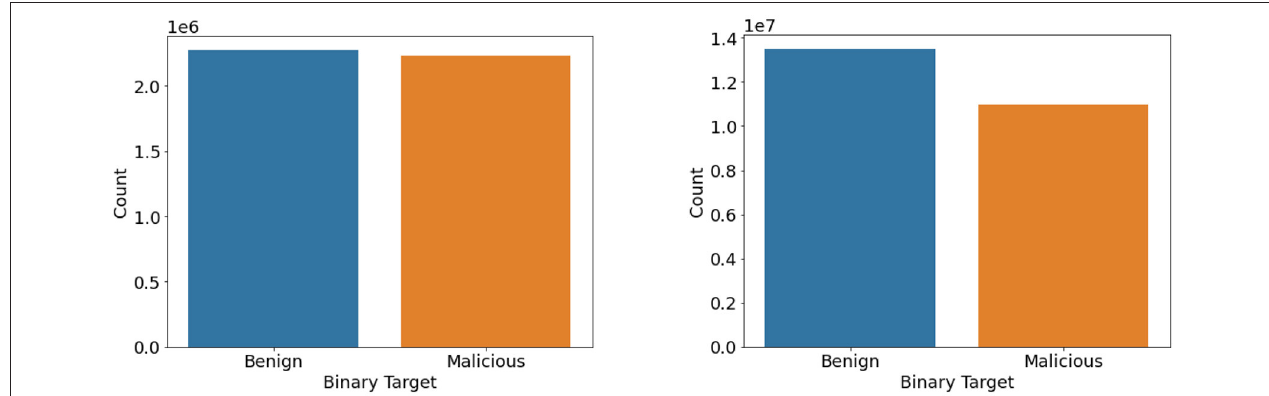
FIGURE 5 | Binary class count plot of oversampled CIC IDS 2017 (left) and 2018 (right)